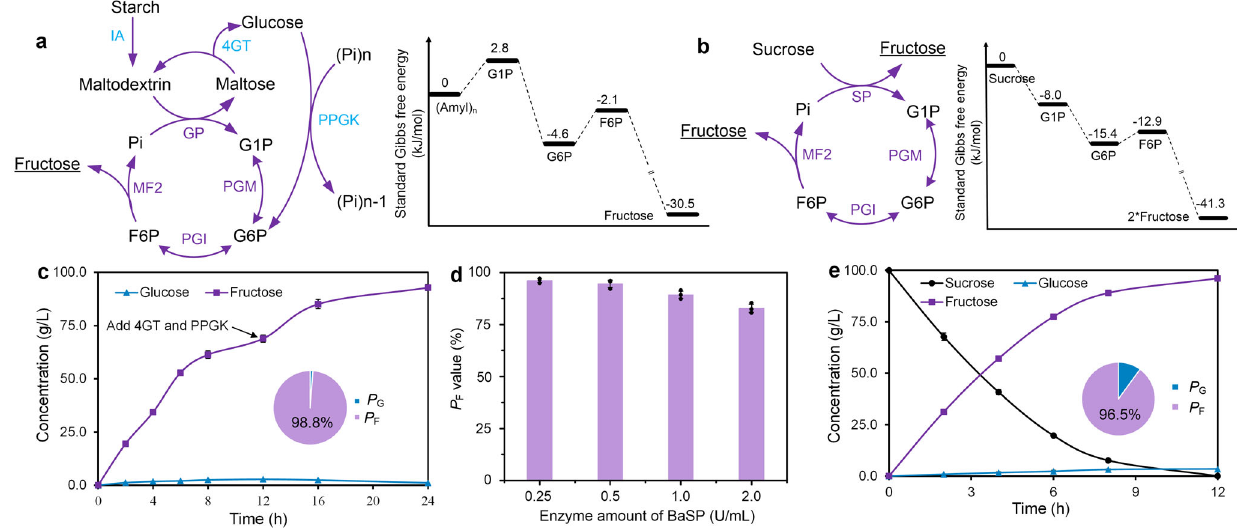
Fig. 5 Biosynthesis of fructose from starch and sucrose by constructing multienzyme systems. a Thermodynamically-driven manufacturing fructose from starch. The standard Gibbs free energy change of each and overall reaction was presented. The Δ G° value was freely available on the website. http://equilibrator.weizmann.ac.il. (Pi)n: hexametaphosphate, (Amyl)n: maltodextrin. b Thermodynamically-driven manufacturing fructose from sucrose. c Biosynthesis of fructose under 100 g/L of maltodextrin. The reaction medium containing maltodextrin (100 g/L), PBS buffer (30 mM, pH 6.5), MgCl 2 (5 mM), TmGP (10 U/mL), TkPGM (5 U/mL), TtPGI (10 U/mL), and MF2 (10 U/mL) was carried out at 55°C for 24 h. After reaction for 12 h, 5.0 U/mL of Tl4GT, 5.0 U/mL of TfPPGK, and 50 mM of hexametaphosphate were added to the reaction solution. d The effect of enzyme amount of BaSP on P F values. e Biosynthesis of fructose under 100 g/L of sucrose. The reaction medium comprising of 100 g/L of sucrose, 20 mM of PBS buffer (pH 6.5), 5 mM of MgCl 2 , 2.5 U/mL of BaSP, 5 U/mL of TkPGM, 10 U/mL of TtPGI, and 10 U/mL of MF2 was carried out at 55 °C for 12 h. Data are presented as mean values + / − SD ( n = 3 independent experiments). Source data for c – e are provided as a Source Data fi le.